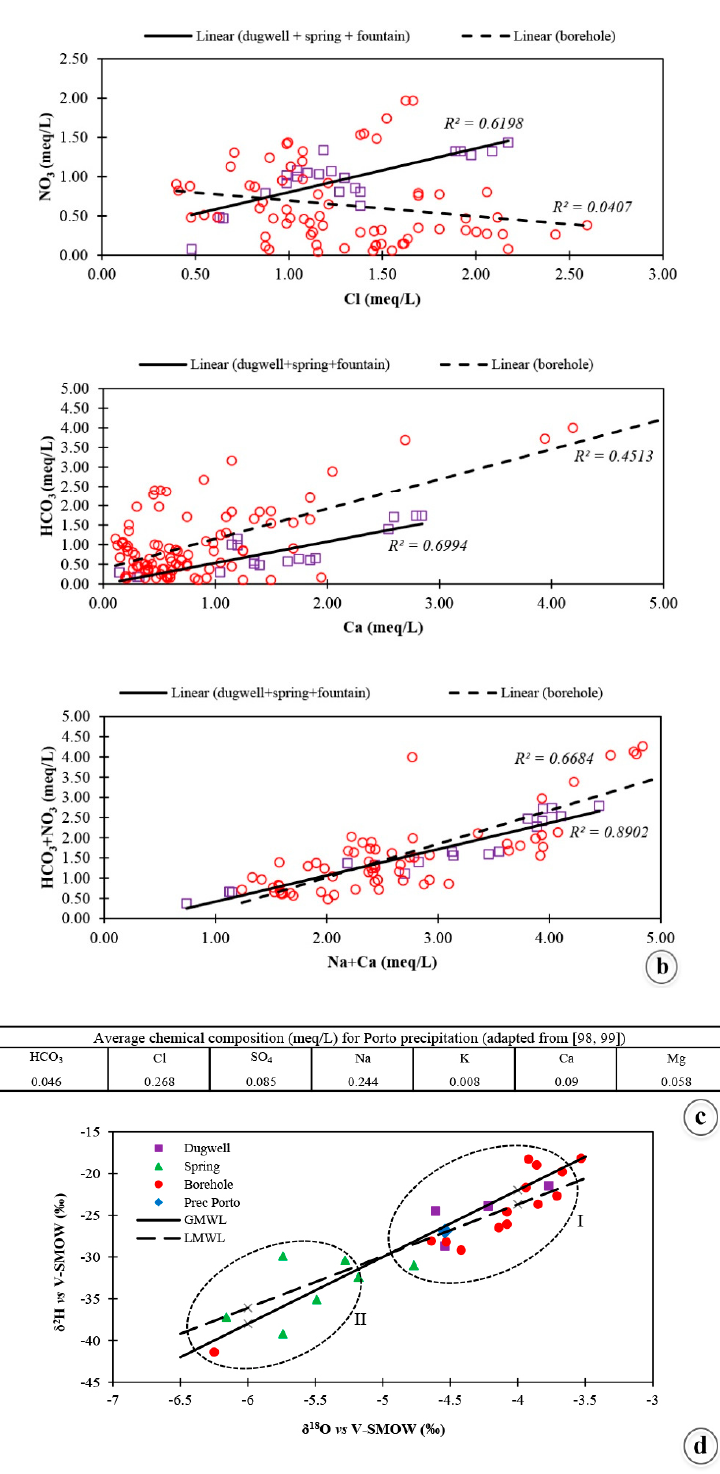
Figure 3. Hydrochemical and isotopic relationships for groundwater samples collected during the three Figure 3. cont . fieldwork campaigns. ( a ) Piper diagram; ( b ) Scatter diagrams for several hydrochemical parameters, R-squared value ( R 2 ) is indicated for each studied linear relationship, and seawater relations are those reported by [85]; ( c ) The average chemical composition of Porto precipitation, reported by [98] and [99]; ( d ) δ 18 O vs. δ 2 H signatures of the studied groundwater samples. The global meteoric water line (GMWL) ( δ 2 H = 8 δ 18 O + 10, [89]), the local (Porto meteorological station) meteoric water line (LMWL) ( δ 2 H = (6.20 ± 0.33) and δ 18 O + (1.12 ± 1.16), r = 0.93, [93]), and the long-term mean isotopic composition of Porto precipitation (Prec. Porto) ( δ 2 H = − 26.9% (cid:24) and δ 18 O = 4.54 [93]) were plotted as